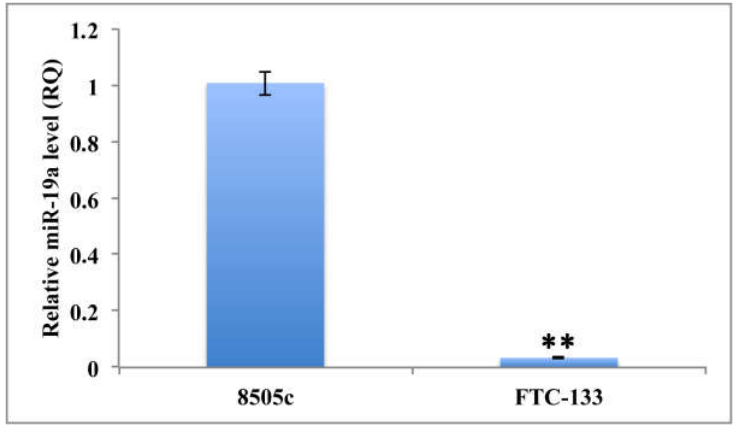
Figure 1. Quantitation of relative miR-19a expression levels on 8505c and FTC-133 cell lines in basal condition. U6 has been used as endogenous control. Student t-test p value ( p < 0.0001) is reported and indicates significant difference between the two groups.